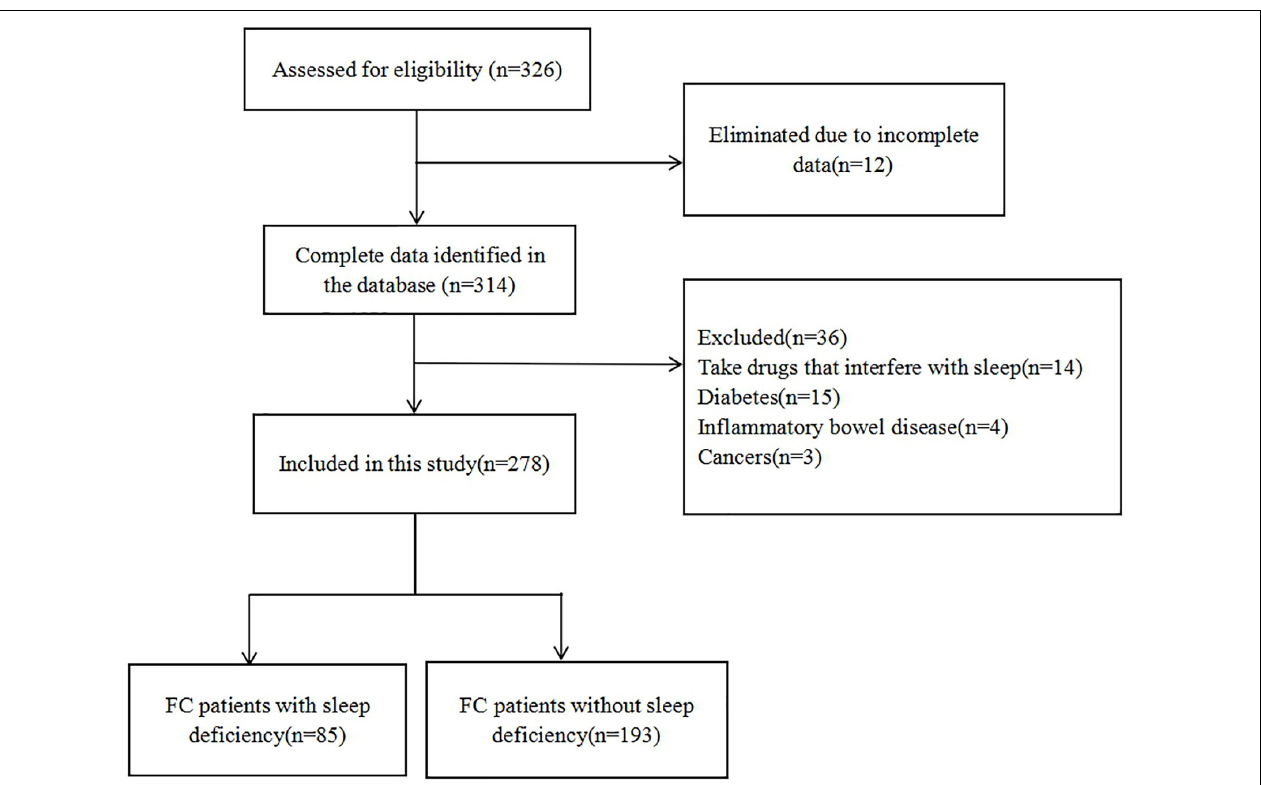
FIGURE 1 | Flow chart of FC patient recruitment in this